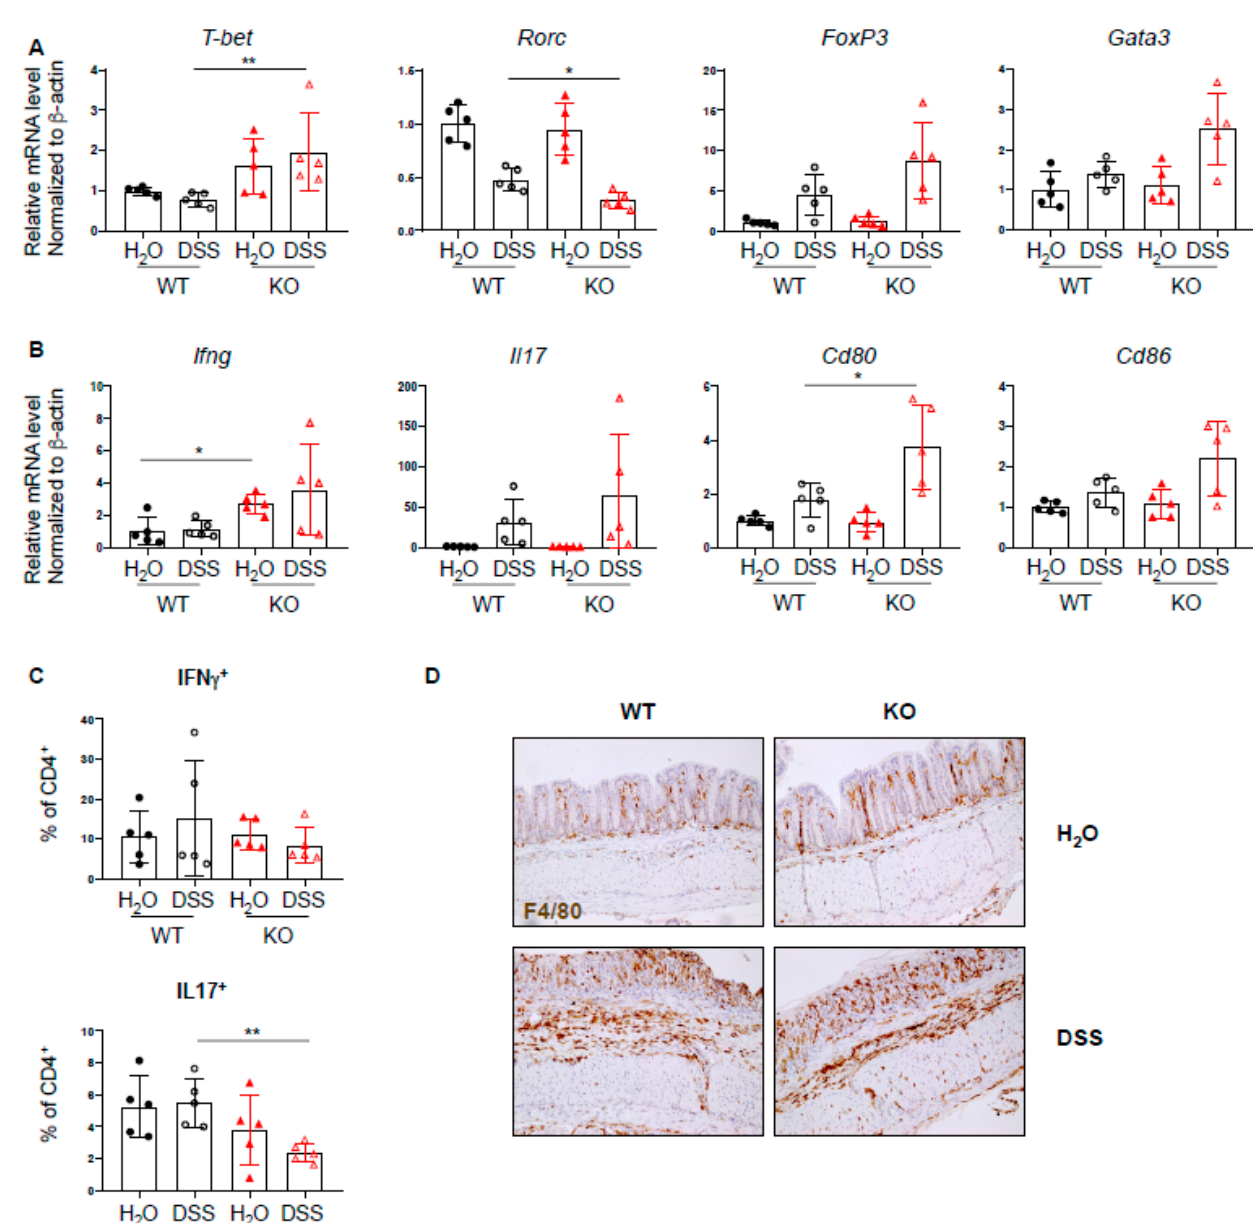
Figure 3. Increased Th1 response in PTPN2 fl/fl xCD11c Cre mice in acute colitis. RNA was isolated from whole colon pieces of PTPN2 fl/fl (WT) and PTPN2 fl/fl xCD11c Cre (KO) mice: ( A , B ) mRNA expression of the indicated; ( A ) Th-cell-associated transcription factors; ( B ) cytokines and activation markers in whole colon lysates; ( C ) frequencies of IFN γ + and IL17 + CD4 + T cells in lamina propria; ( D ) IHC staining for F4/80 + macrophages in the colon. * p < 0.05, ** p < 0.01; unpaired Mann–Whitney test. Data are representative for one out of two independent experiments with 4–5 mice per experimental group.